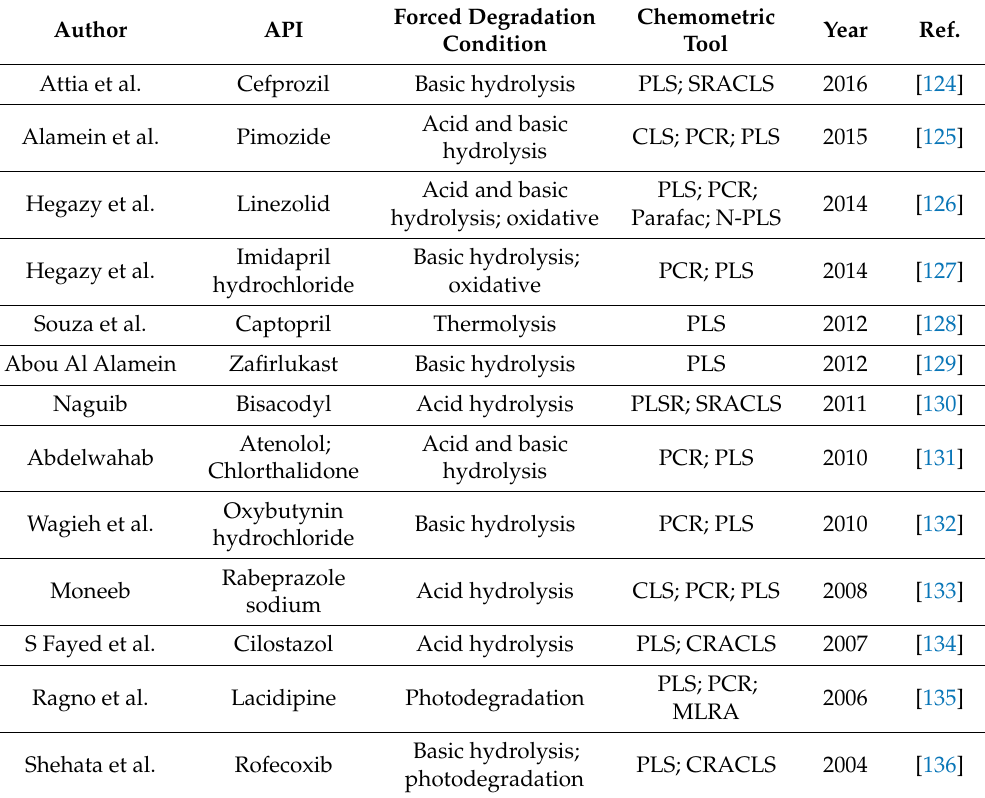
Table 8. Works involving forced degradation studies and the partial least squares (PLS)